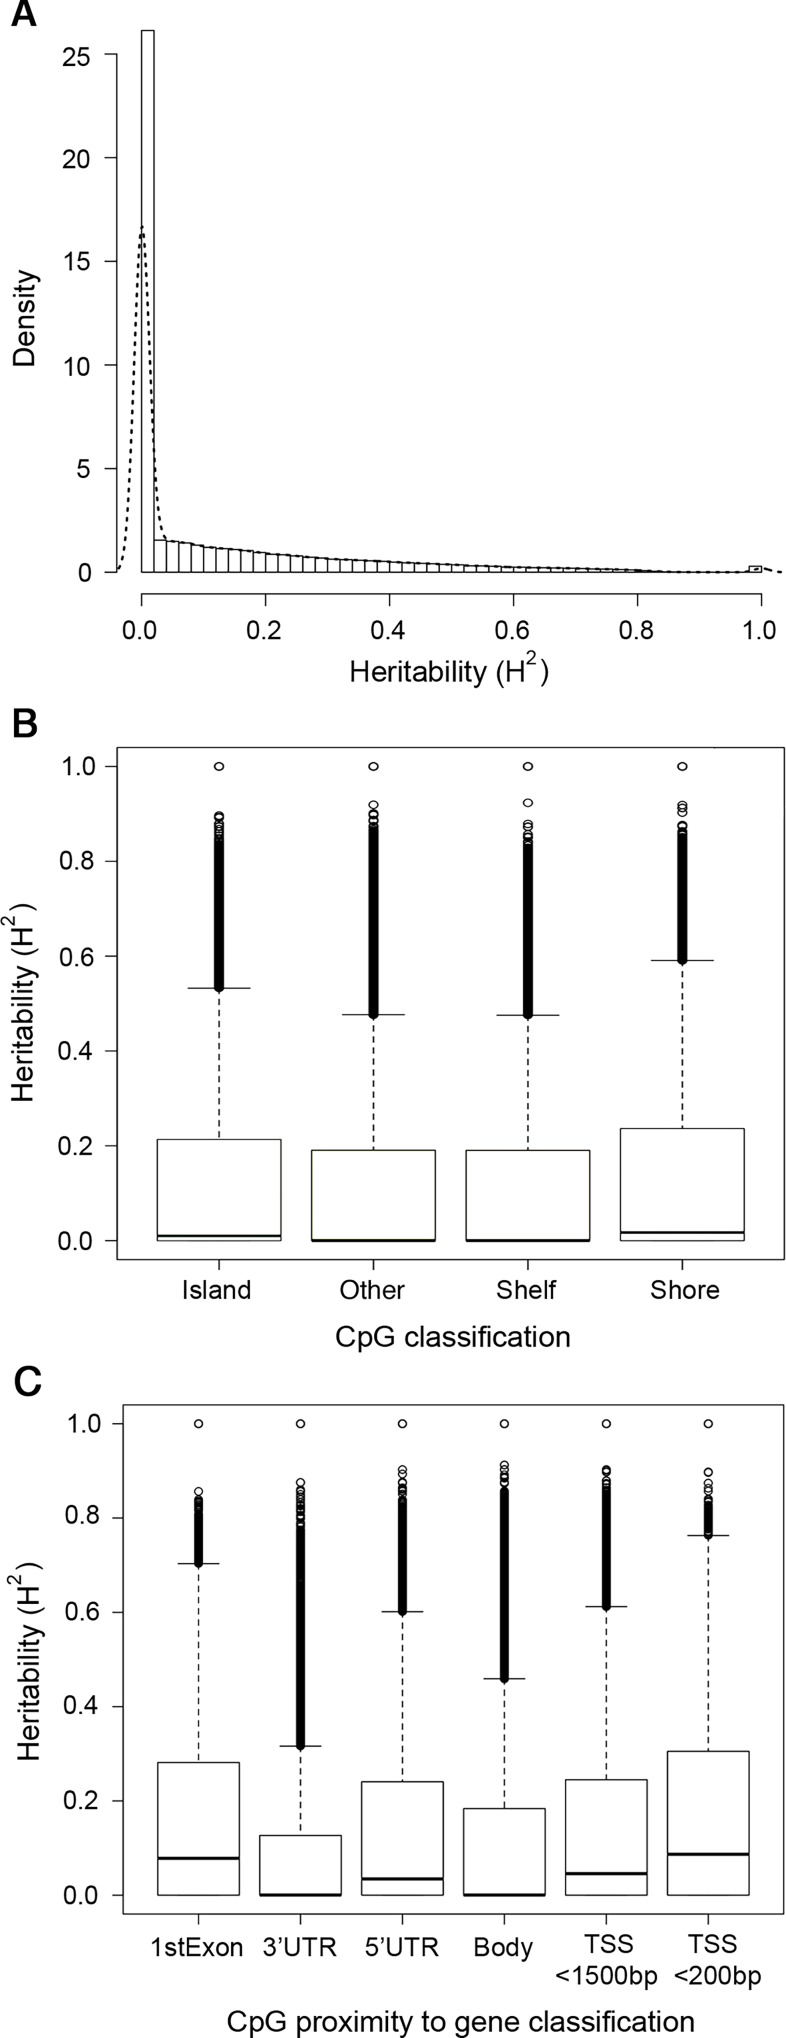
Distributions of heritability values by CpG island proximity and gene region.Histogram of heritability values (A) for all 174,445 tested CpGs with overlaid density estimate (dotted-line) and boxplots of heritability values for CpGs annotated by CpG-island proximity (B), and gene region (C).